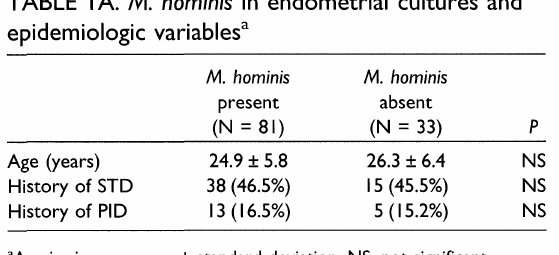
TABLE A. M. hominis in endometrial cultures and epidemiologic variables